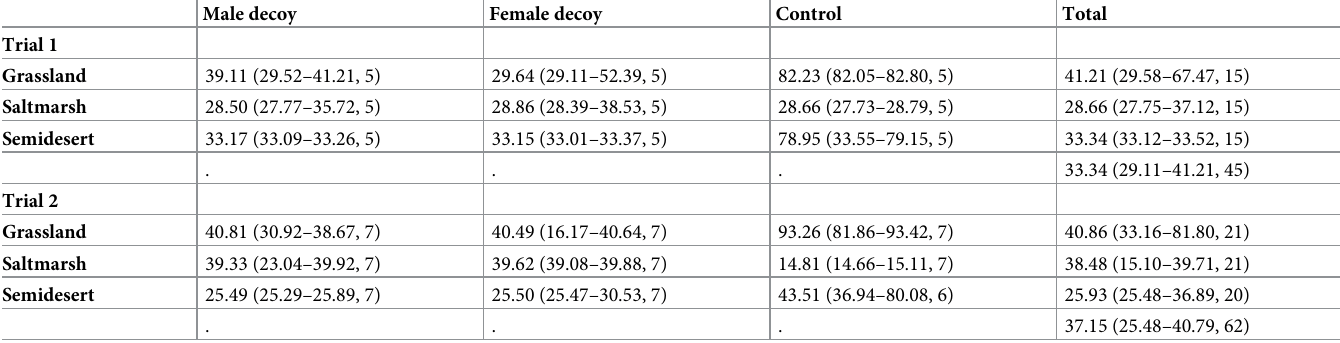
Table 1. Survival summary of the three treatments Male decoy , Female decoy and Control in the three distinct habitats Grassland , Saltmarsh and Semidesert for Trial 1 and Trial 2. Male decoy